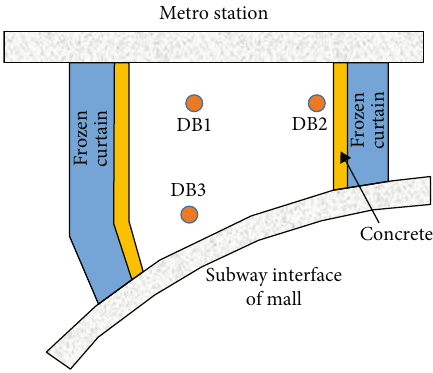
Figure 4: Position of displacement monitoring